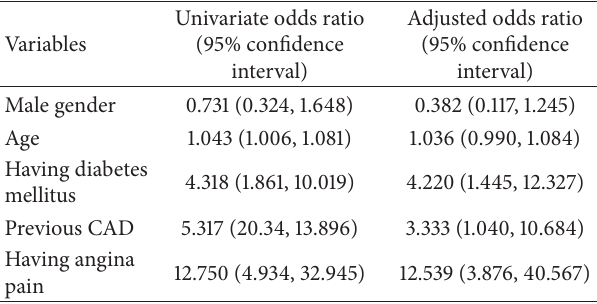
Table 2: Factors associated with having acute coronary syndrome by logistic regression